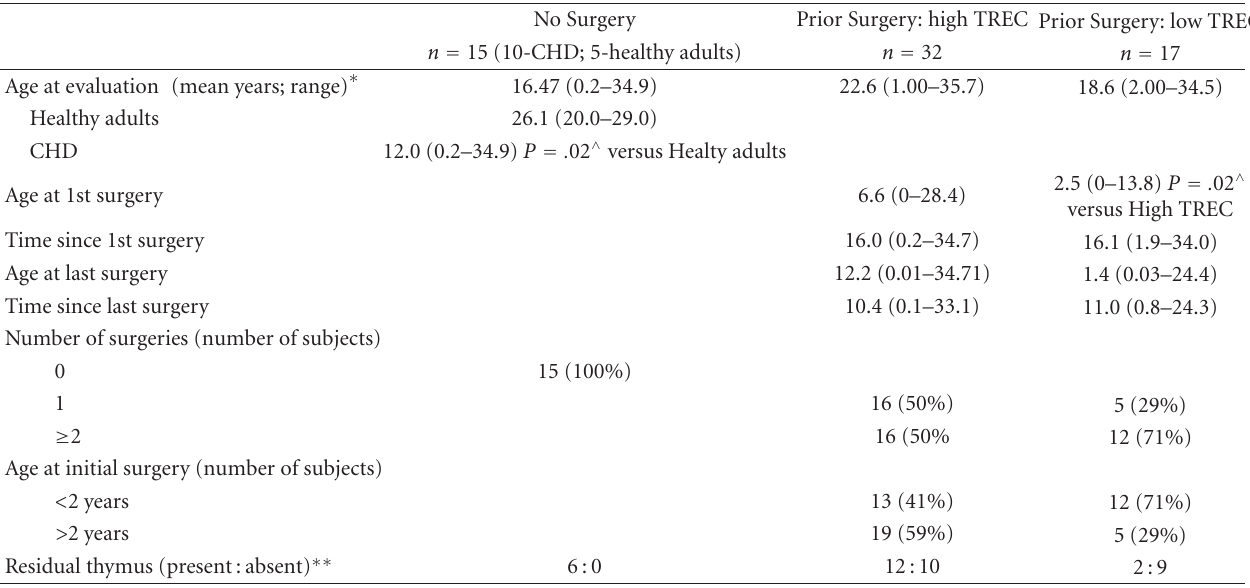
Table 1: Characteristics of